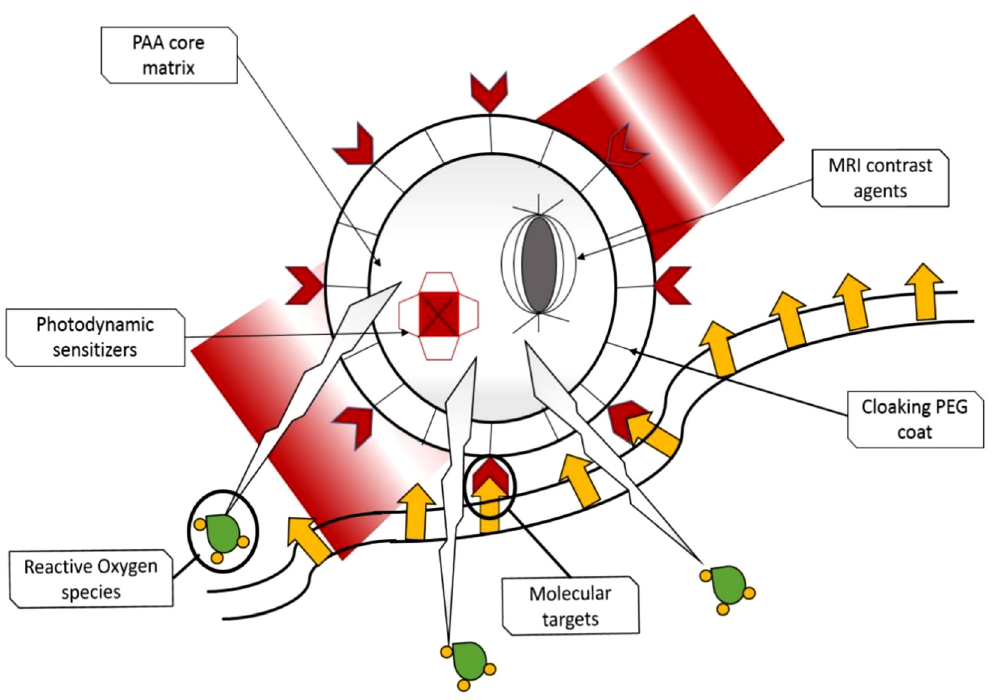
Figure 24: The schematic nanoplatform consisting of PAA core matrix with PEG cloaking coat, photodynamic dye (Photofrin ® ), MRI contrast enhancement agents and molecular targeting (cRGD peptide). Adapted from Kopelman et al.